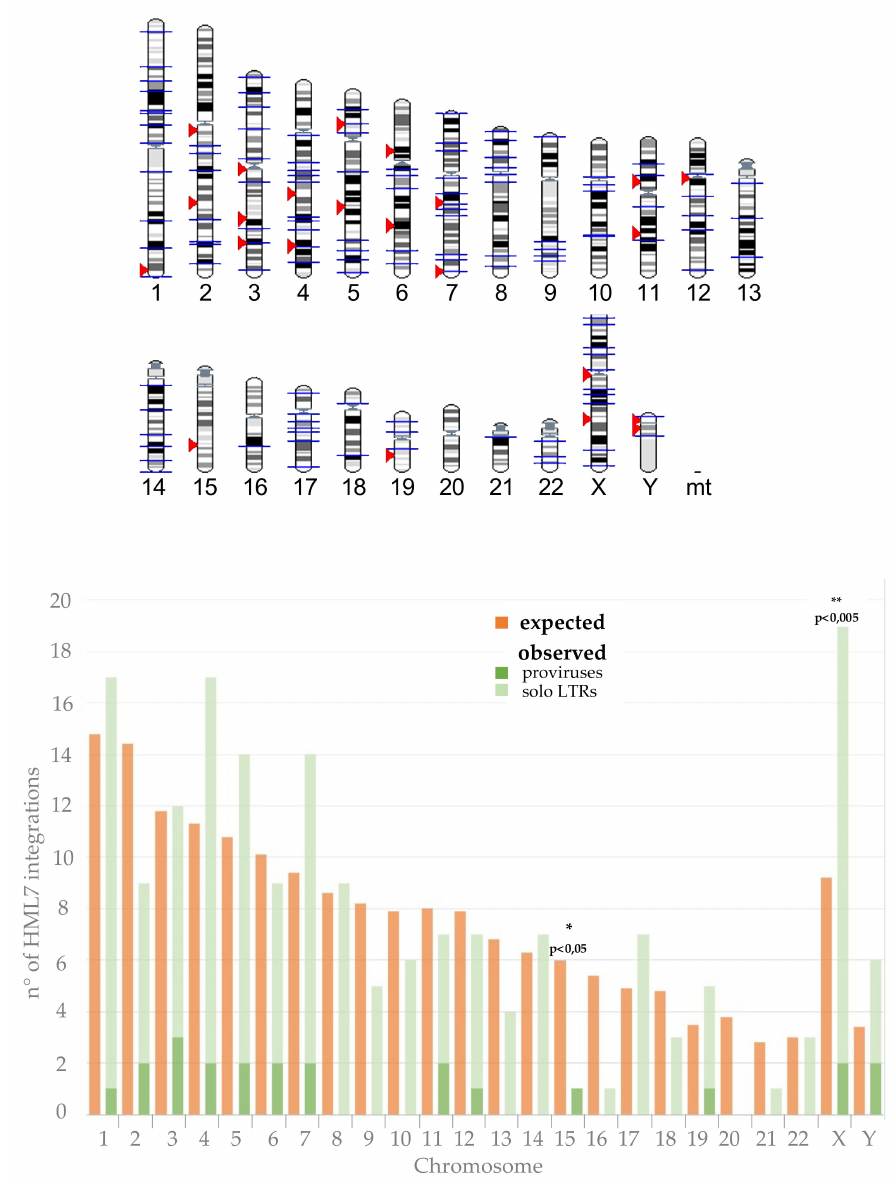
Figure 1. Chromosomal distribution of HML7 loci. In the upper part of the figure, HML7 proviruses (red arrows) and solitary LTRs (blue lines) have been visualized on the human karyotype (source: www.ensembl.org (accessed on 30 March 2021)). In the lower part of the figure, the observed chromosomal distribution of HML7 elements was statistically compared to the expected one, showing significant decrease in chromosome 15 and enrichment in chromosome X